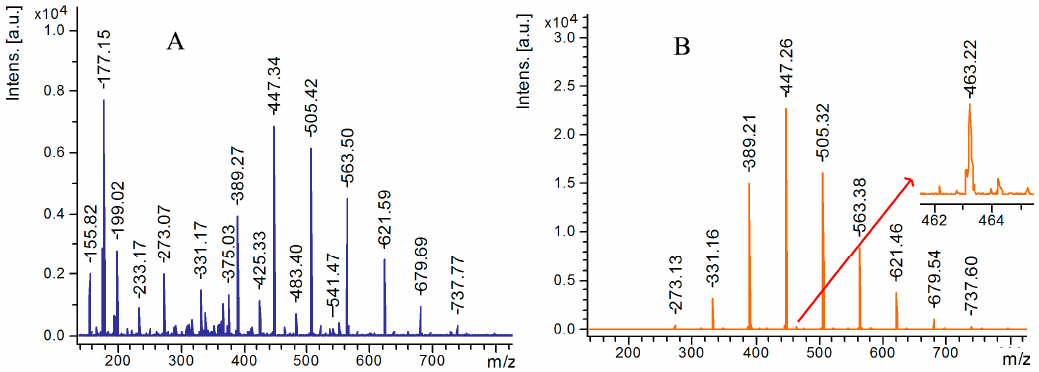
Figure 5. Matrix assisted laser desorption/ionization (MALDI) time-of-flight mass spectrometry (TOF MS) spectra of a low molecular weight polypropylene glycol (PPG) (ca. 425 Da) obtained from analyses by ( A ) MALDI with 2,5-dihydroxybenzoic acid (DHB) as a matrix and ( B ) laser desorption/ionization (LDI) on the layer of graphene nanoparticles (GN). Reproduced with permission of [121].